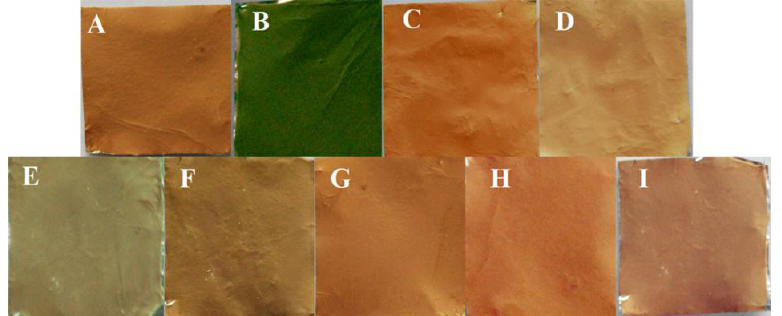
Figure 5. Photographs of the ZPCPI nanofibrous membrane when exposed to different vapors (30 ppm). ( A ) Blank; ( B ) Pyridine; ( C ) DEA; ( D ) TEA; ( E ) Py; ( F ) CA; ( G ) CO ( H ) H O; and ( I ) recovered when puffed with N 2